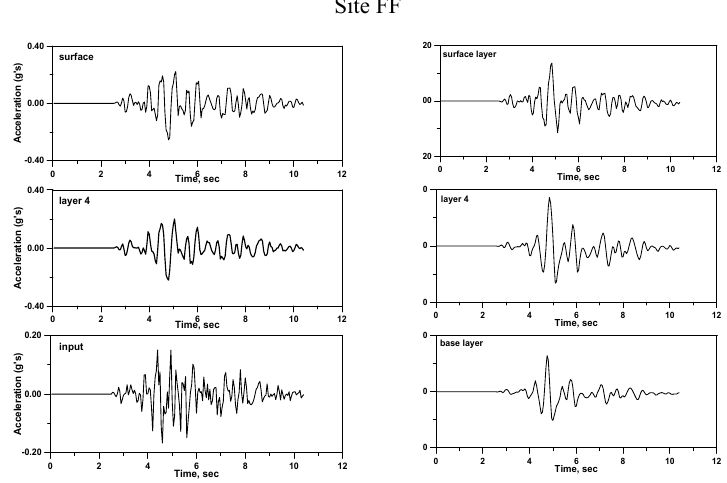
Fig. 21. Acceleration (left column) and strain (right column) time histories at different ground